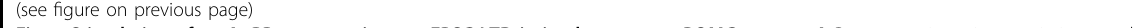
Fig. 1 Stimulation of an AgRP neuron triggers sEPSC LTD in its downstream POMC neuron. A Representative microscopic images showing GFP-labelled AgRP neurons (left), tdTOMATO-labelled POMC neurons (middle), and merge (right) from NPY-GFP/POMC-CreERT2/Rosa26-LSL- tdTOMATO mice. B , C Representative action potential traces from an AgRP neuron and a POMC neuron that do not form a synapse (B) or from a pair that forms a synapse ( C ). D , E Representative traces for IPSCs recorded from a POMC neuron upon a positive current injected into its pre-synaptic AgRP neuron, in the absence ( D ) or the presence ( E ) of 4-AP and TTX. F , G Quanti fi cations of IPSC amplitude ( F ) and latency ( G ). Data are mean ± SEM. n = 7 per group. *** P < 0.001 vs. 1st group; ### P < 0.001 vs. 2nd group in one-way ANOVA analyses followed by Tukey ’ s tests. H Schematic protocol to induce sEPSC LTD at the AgRP → POMC synapse. I Upper panel: representative sEPSC traces at the baseline and after AgRP neuron stimulation recorded from the POMC neuron that was synapsed by the AgRP neuron. Lower panel: quantitative changes in sEPSC amplitudes (as % of the baseline) in POMC neurons before and after the 10-min AgRP neuron stimulation. Data are mean ± SEM. n = 6 per group. J Upper panel: representative sEPSC traces at the baseline and after AgRP neuron stimulation recorded from the POMC neuron that was not synapsed by the AgRP neuron. Lower panel: quantitative changes in sEPSC amplitudes (as % of the baseline) in POMC neurons before and after the 10-min AgRP neuron stimulation. Data are mean ± SEM. n = 6 per group. Also see Fig.